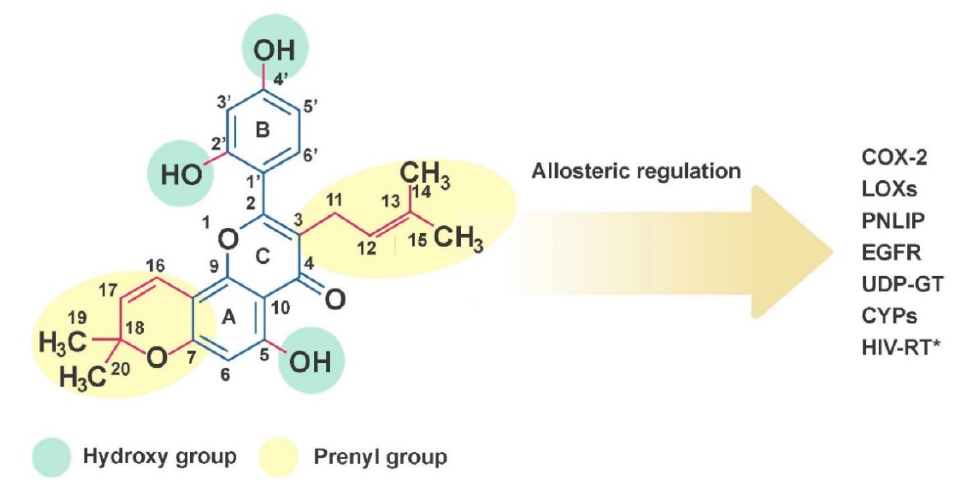
Figure 1. The chemical structure of morusin. Molecular targets of morusin include cyclooxygenase-2 (COX-2), lipoxygenases (LOXs), pancreatic lipase (PNLIP), epidermal growth factor receptor (EGFR), UDP-glucuronosyltransferase, cytochrome P450 (CYP) and HIV reverse transcriptase (* in silico analysis only).